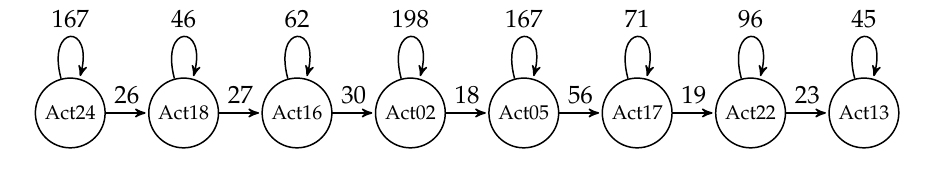
Figure 1. User: Mario, Date: 31 October, Type: